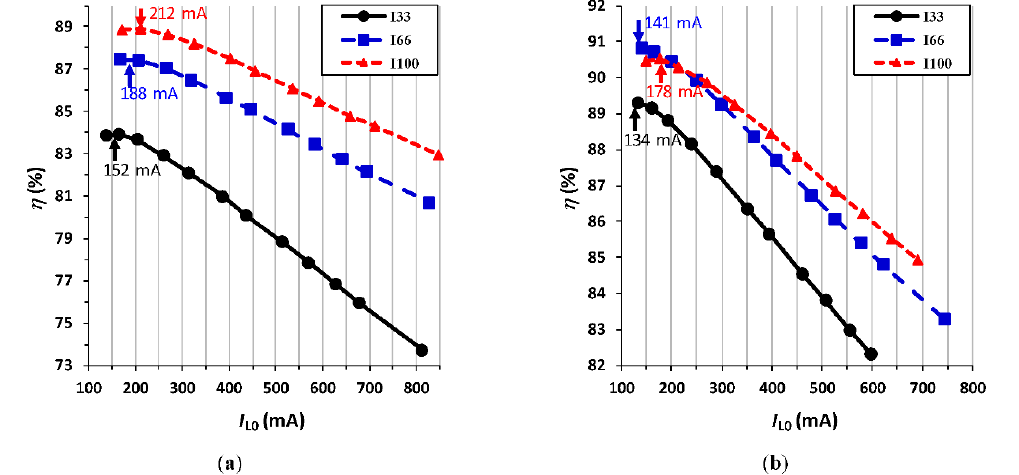
Figure 3. Efficiency versus I L0 when regulating the operating voltage of ( a ) PV-1; ( b )